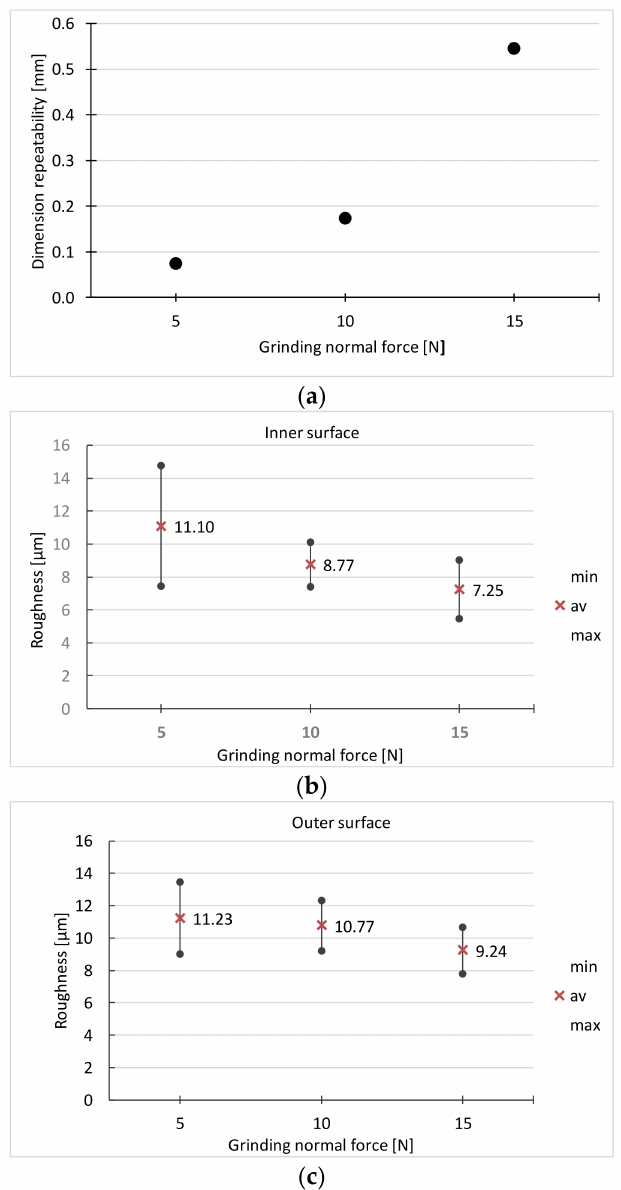
Figure 11. Dependence on the ginding force of: ( a ) dimensional repeatability, ( b , c ) surface roughness ( v s = 26 m/s; v f = 4